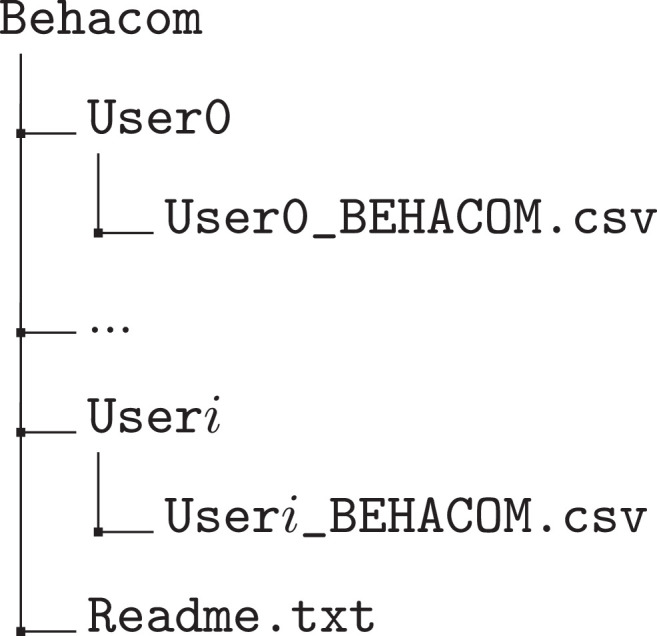
Data repository [1] structure.